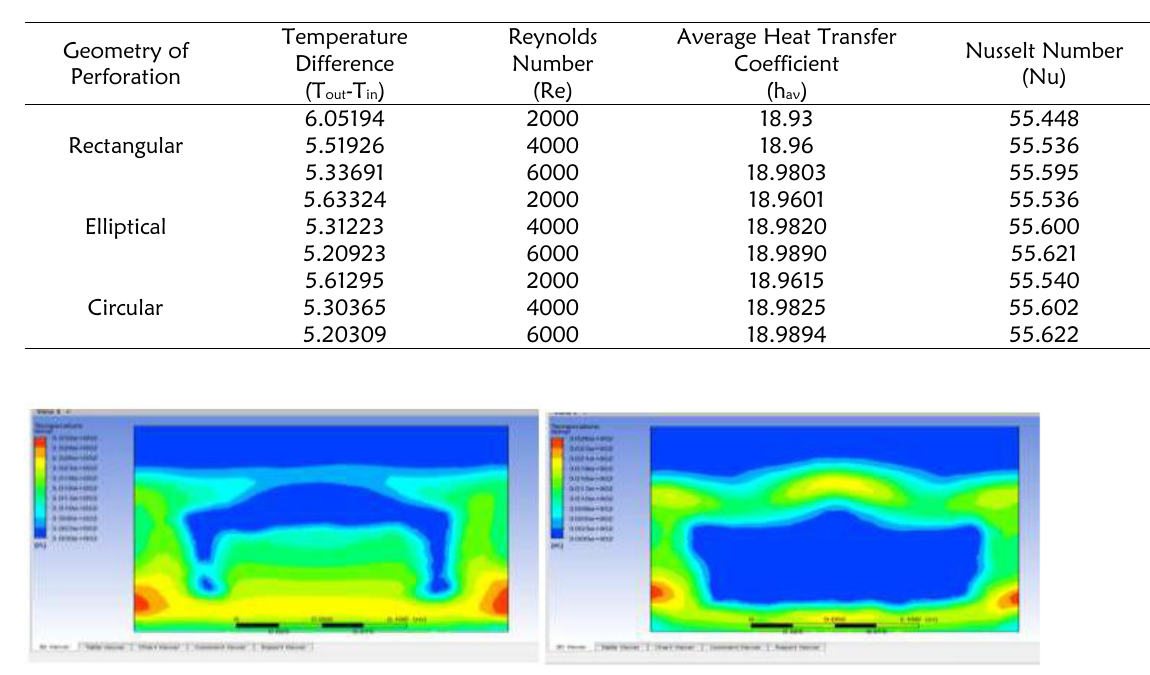
Table 2: Values of average heat transfer coefficient (h av ) and Nusselt number (Nu) for different cases [71]